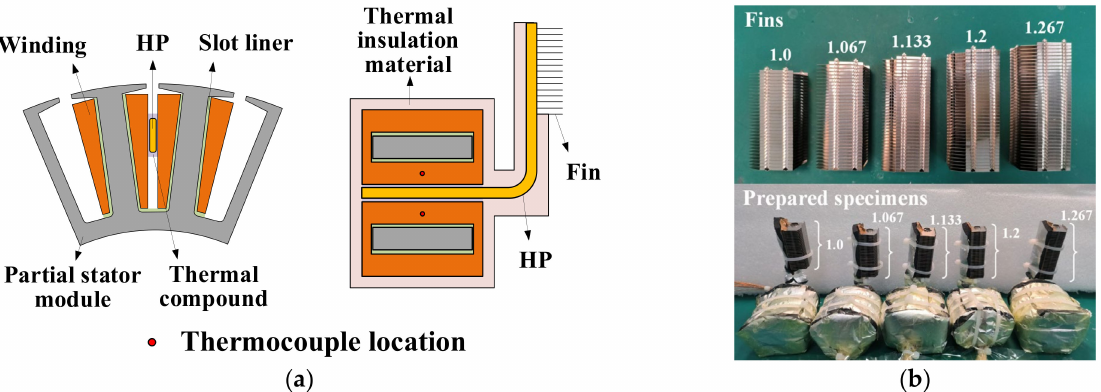
Figure 13. Specimen preparation with five different fin areas. ( a ) Schematic of the specimen construc- tion based on a partial stator-winding assembly. ( b ) Five prepared